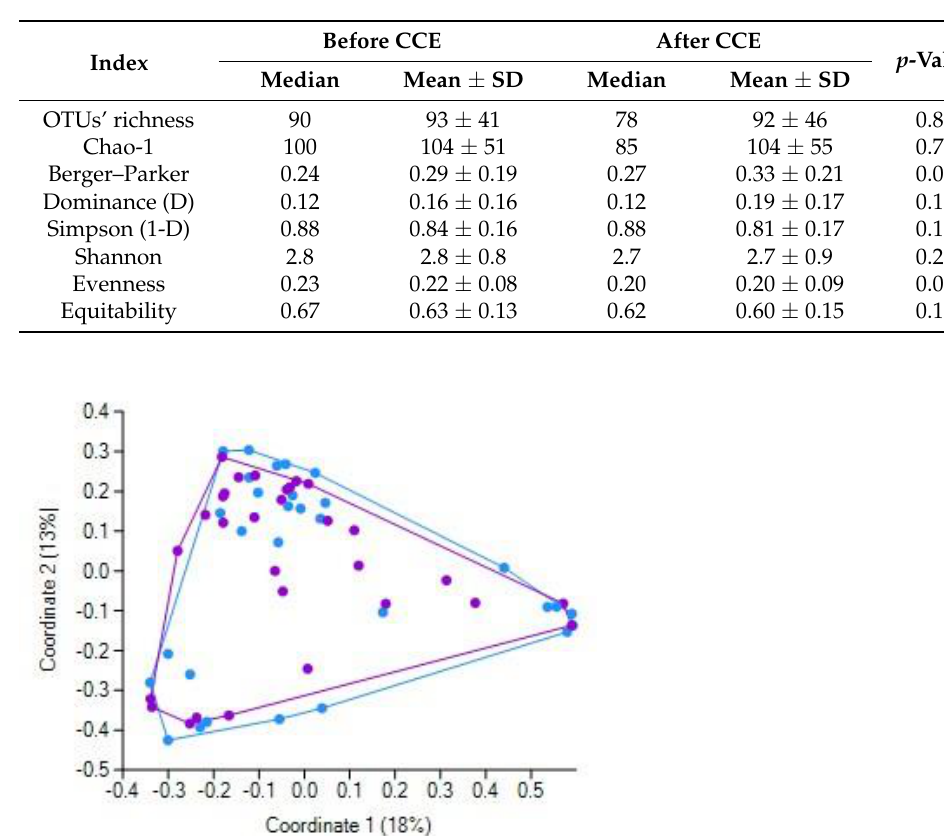
Table 7. Alpha-diversity indices estimated for patients ’ fecal bacterial assemblages before and after CCE.